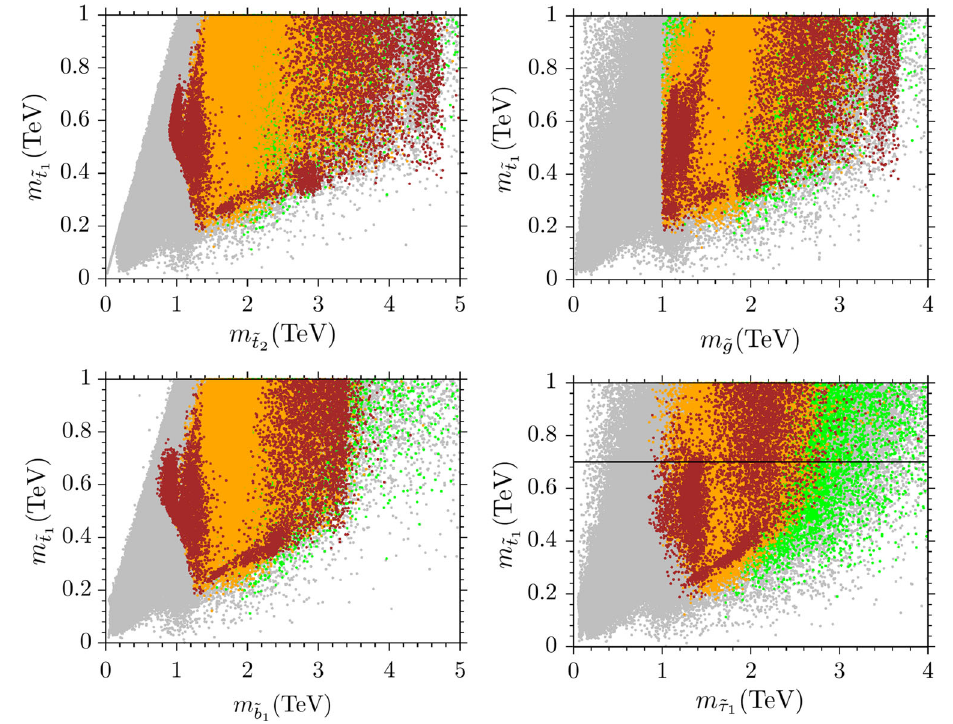
− m ˜ − m ˜ − m ˜ − m ˜ τ , and m ˜ t . The color coding is the same as the right panel of Fig. 3. g , m ˜ t 1 t 2 , m ˜ t 1 b 1 1 1 1 (cid:2) 700 GeV). t 1